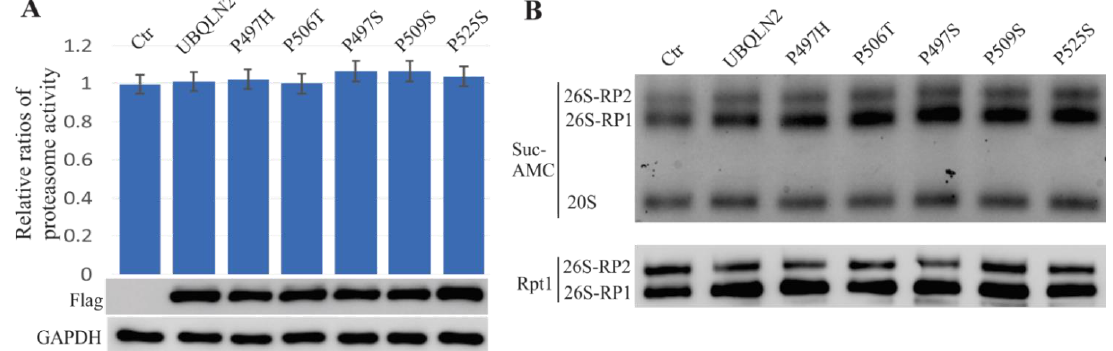
Figure 6. Mutant UBQLN2 does not lead to proteasome impairment in HEK-293T cells. Cells were transfected with either wild-type UBQLN2 or with ALS/FTD-linked UBQLN2 mutants and harvested cells in 48 h after transfection. ( A ). The chart revealed that the overall activity of proteasomes was measured using the Suc-AMC substrate, and the immunoblot assay showed similar expression levels for the wild-type and mutant UBQLN2 transfections. ( B ). The in-gel assay assessment revealed that 26S proteasome assembly was not impaired in mutant UBQLN2 transfected cells.